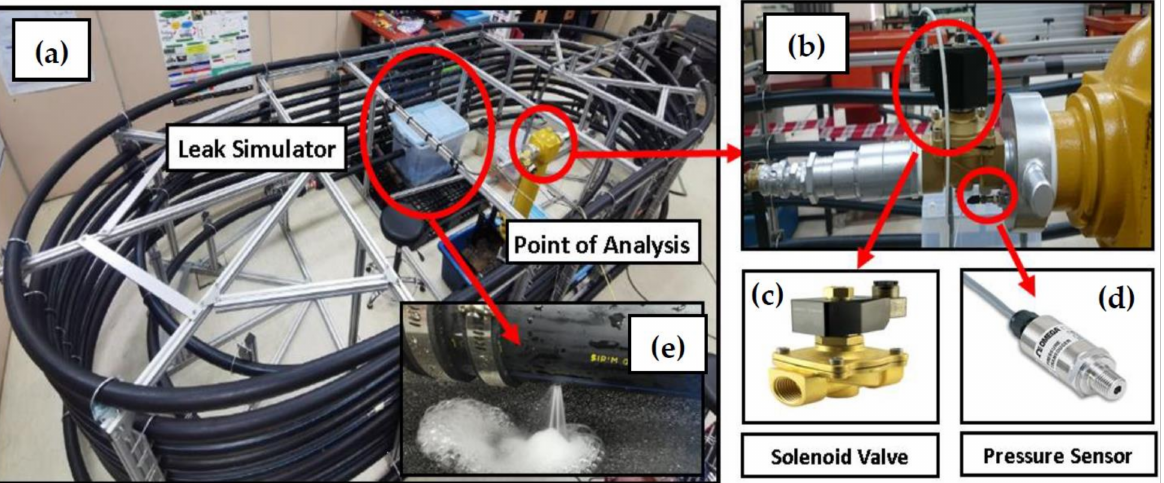
Figure 4. The laboratory experimental set-up: ( a ) Pipe loop; ( b ) Modified fire hydrant cap; ( c ) Solenoid valve; ( d ) Pressure transducer; ( e ) Circular hole (leak